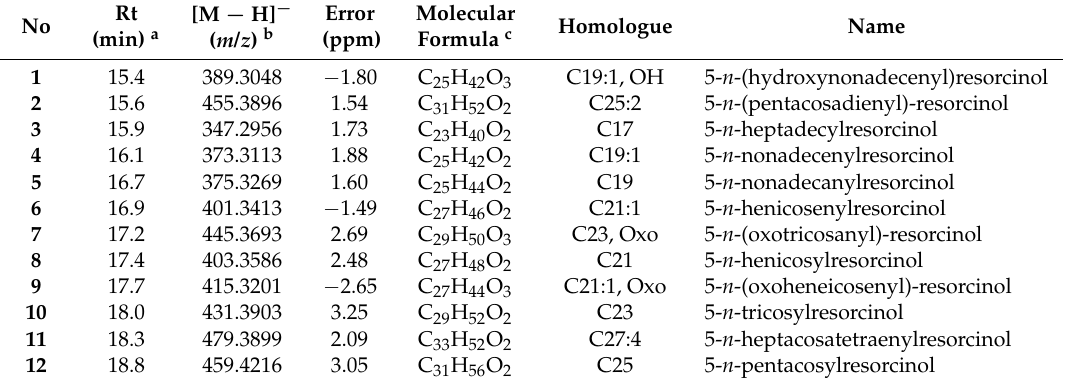
Table 3. Annotated 5- n -alk(en)ylresorcinols homologues in acetone extracts, using LC-ESIMS (in negative ion mode).